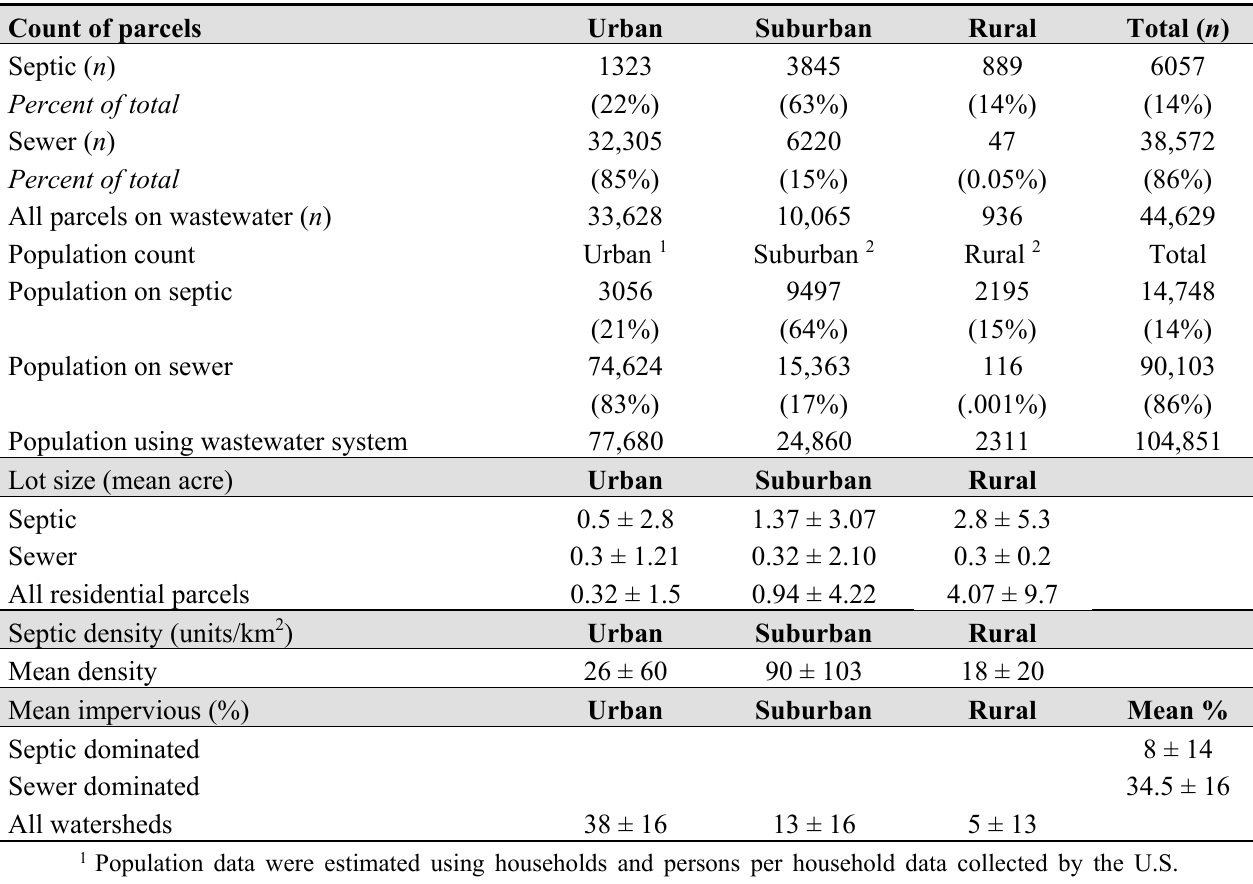
Table 2. Summary results of residential wastewater infrastructure patterns across a coastal urban gradient. Data are from Spirandelli, 2014